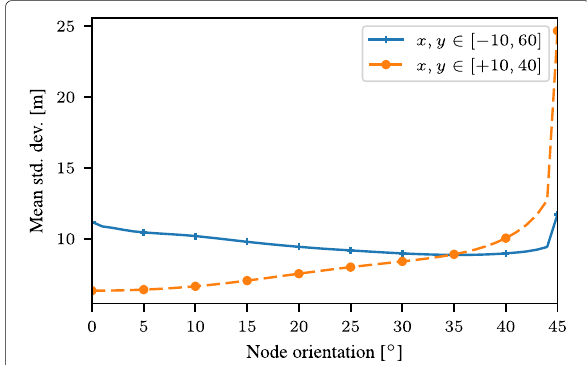
Fig. 5 Optimization of node orientation for the considered network. The lines denote the two considered areas of interest (cf. Fig.